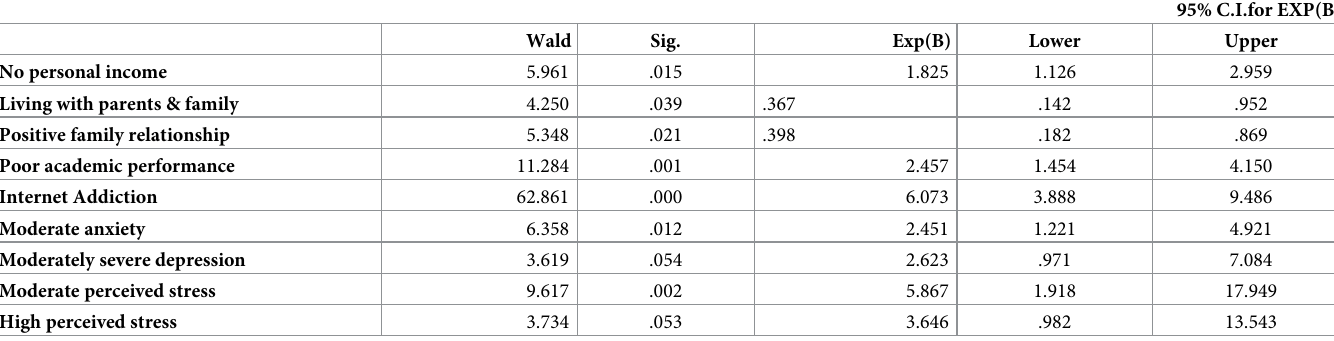
Table 5. Predictors for Facebook Addiction [Dependent variable: BFAS polythetic scheme-based Facebook Addiction categories